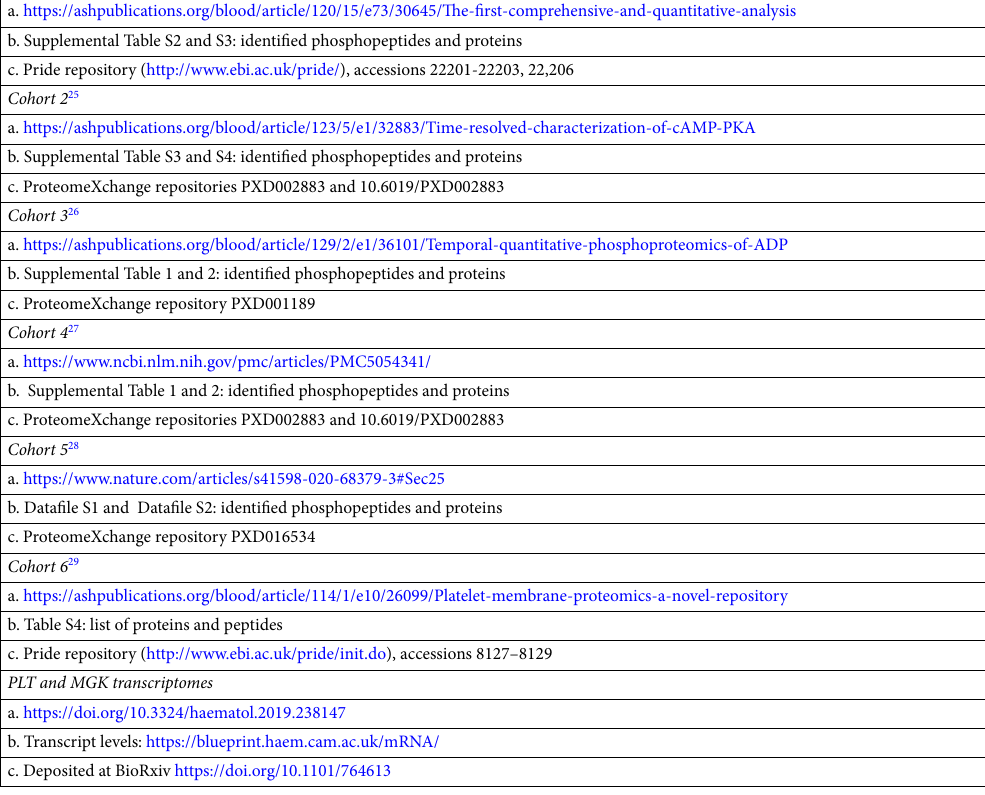
b. Table S4: list of proteins and